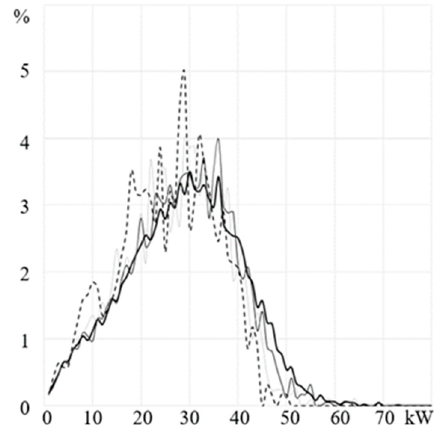
Figure 5. Powers of the storage system and correspondent stored energy, in percentage.